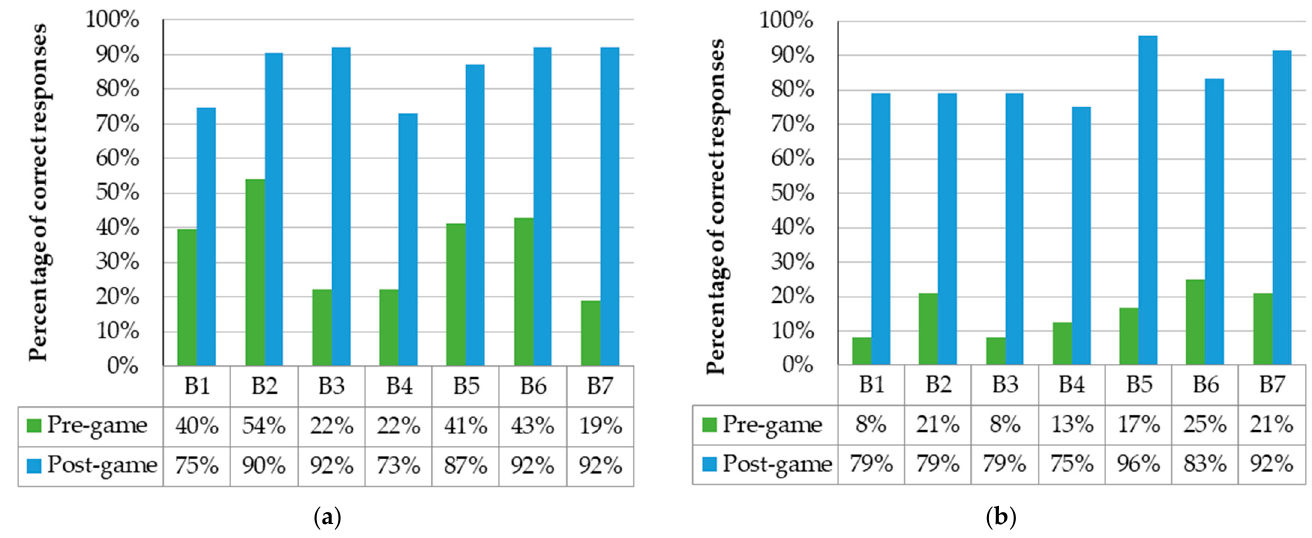
Figure 9. Correct pre-game and post-game responses of Colombian and Chilean students. ( a ) Colombian students; ( b ) Chilean students